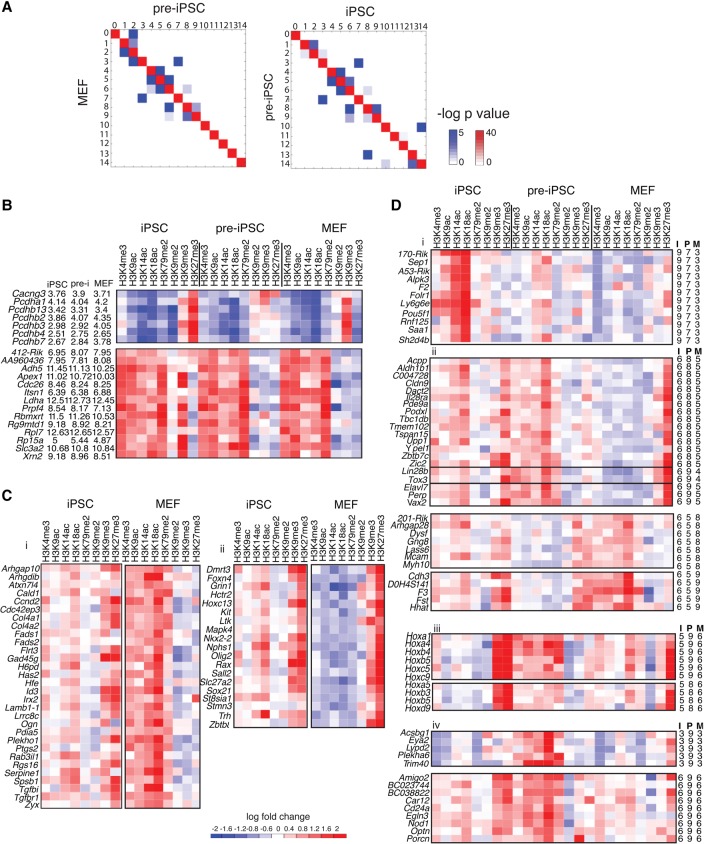
Chromatin module transitions during reprogramming. (A) Plot of similarity of module membership of genes that change between MEFs and pre-iPSCs (left), and pre-iPSCs and iPSCs (right). Two different colors are used: (red) denotes similarity for modules with the same pattern (diagonal entries); (blue) denotes similarity for modules with different patterns (off-diagonal entries). The more red or blue an entry, the more similar are the matrices. The intensity of red (blue) corresponds to the significance of overlap of regions (genes) between two cell types and is the mean of the negative log of two hypergeometric test P-values. One P-value uses regions from one cell type as the background, and another P-value uses the regions from the second cell type as the background. (B) Example sets of genes that do not change greatly in expression but change in module membership. (Left) Gene names and log gene expression in iPSC, pre-iPSC (pre-i) and MEF. (Right) Heat map of enrichment of all histone modifications in iPSC, pre-iPSC and MEF compared to input. (Red) enriched; (blue) depleted. (412-Rik) 4121402D02Rik. (C) Left and right panels represent different gene sets, each exhibiting a different type of chromatin transition. (Left) Example set of genes that gain multivalency in iPSCs from an active state in MEF. (Right) Example set of genes that gain multivalency in iPSCs from a repressed state in MEF. Gene names are provided on the left. The heat maps show the enrichment of histone marks compared to input in each cell type. (D) Chromatin module dynamics of genes identified using rules encoding patterns. The right panels provide module membership of genes in (I) iPSC, (P) pre-iPSC, and (M) MEF. Gene names are provided on the left, histone modifications in red–blue heatmaps: (red) enriched; (blue) depleted. (i) Example of genes that transition through a multivalent state (module 7) in pre-iPSC to an active state in iPSCs from a repressive state in MEF. (ii) Examples of gene sets that transition to a multivalent state in iPSC (module 6) through activating modules (module 8, 9) in pre-iPSCs (top) or a repressed modules (module 5) in pre-iPSCs (bottom). (iii) Example sets of genes that acquire transient active modifications in pre-iPSC. (iv) Example sets of genes that display an aberrant activated state in pre-iPSC that is not recapitulated in the starting MEF or endpoint iPSC cell types: (170-Rik) 1700061G19Rik; (201-Rik) 2010002N04Rik.